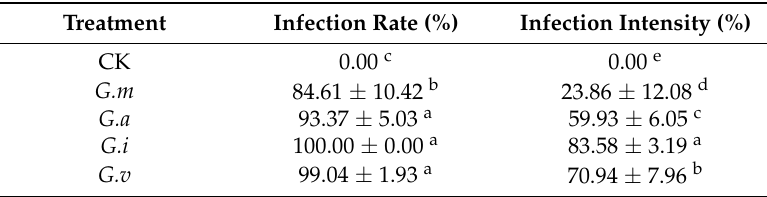
Figure 1. Effect of arbuscular mycorrhizae fungi (AMFs) inoculation on the colonization of S. miltiorrhiza root. Roots were stained by trypan blue, then photographed under a 1000 times microscope. ( A ): root hair; ( B ): spore; ( C ): hypha. CK means with non-AMF inoculation; G.v. means inoculation with arbuscular mycorrhizae (AM) fungus Glomus versiforme ; G.i. means inoculation with AM fungus Glomus intraradices ; G.a. means inoculation with AM fungus Glomus aggregatum ; G.m. means inoculation with AM fungus Glomus mosseae . Table 1. Infection rate and intensity with different AMFs inoculation.